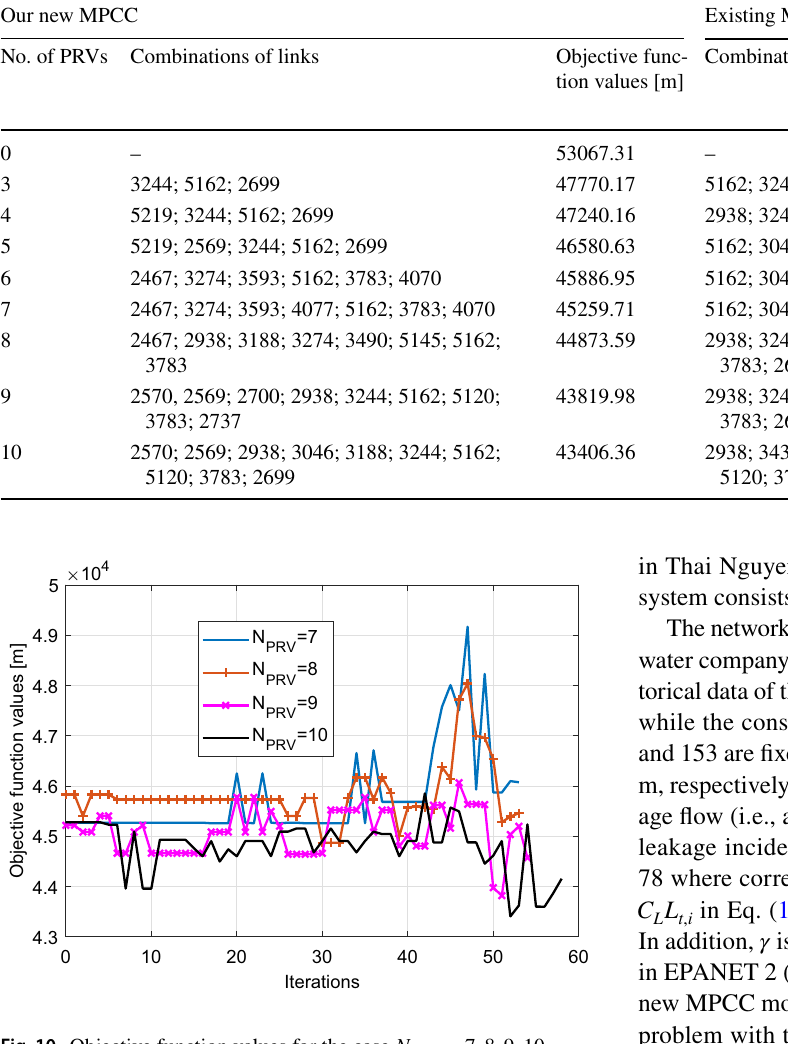
Fig. 10 Objective function values for the case N PRV =